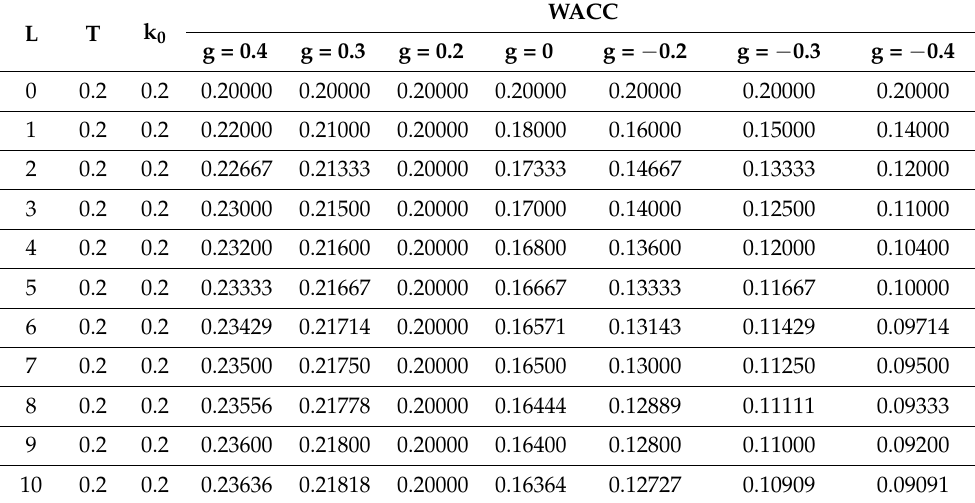
Table 1. Dependence of WACC on leverage level L in Generalized Modigliani–Miller theory